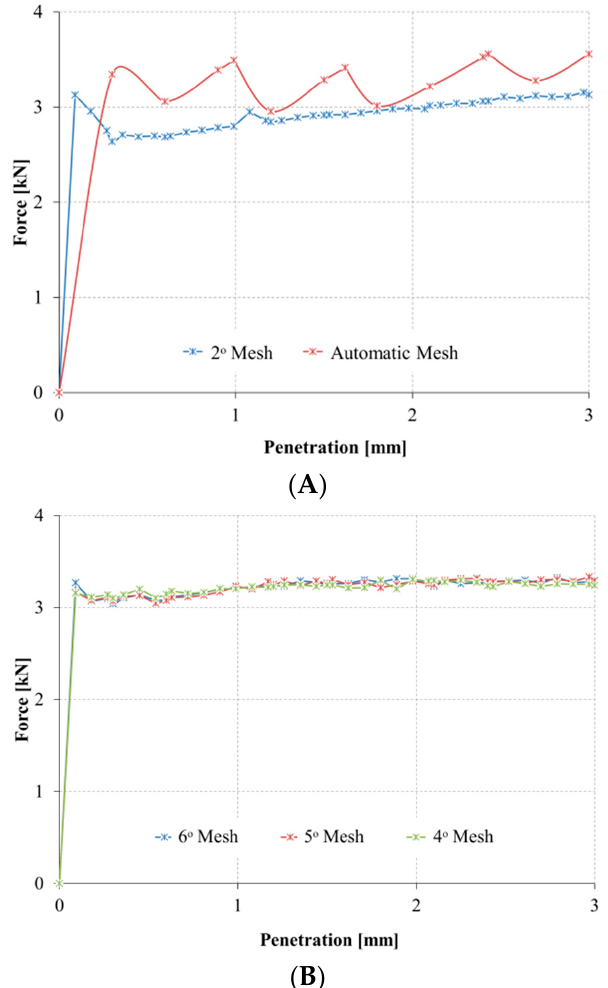
Figure 4. Mesh optimization study. Initial stage ( A ) and optimized mesh ( B ).